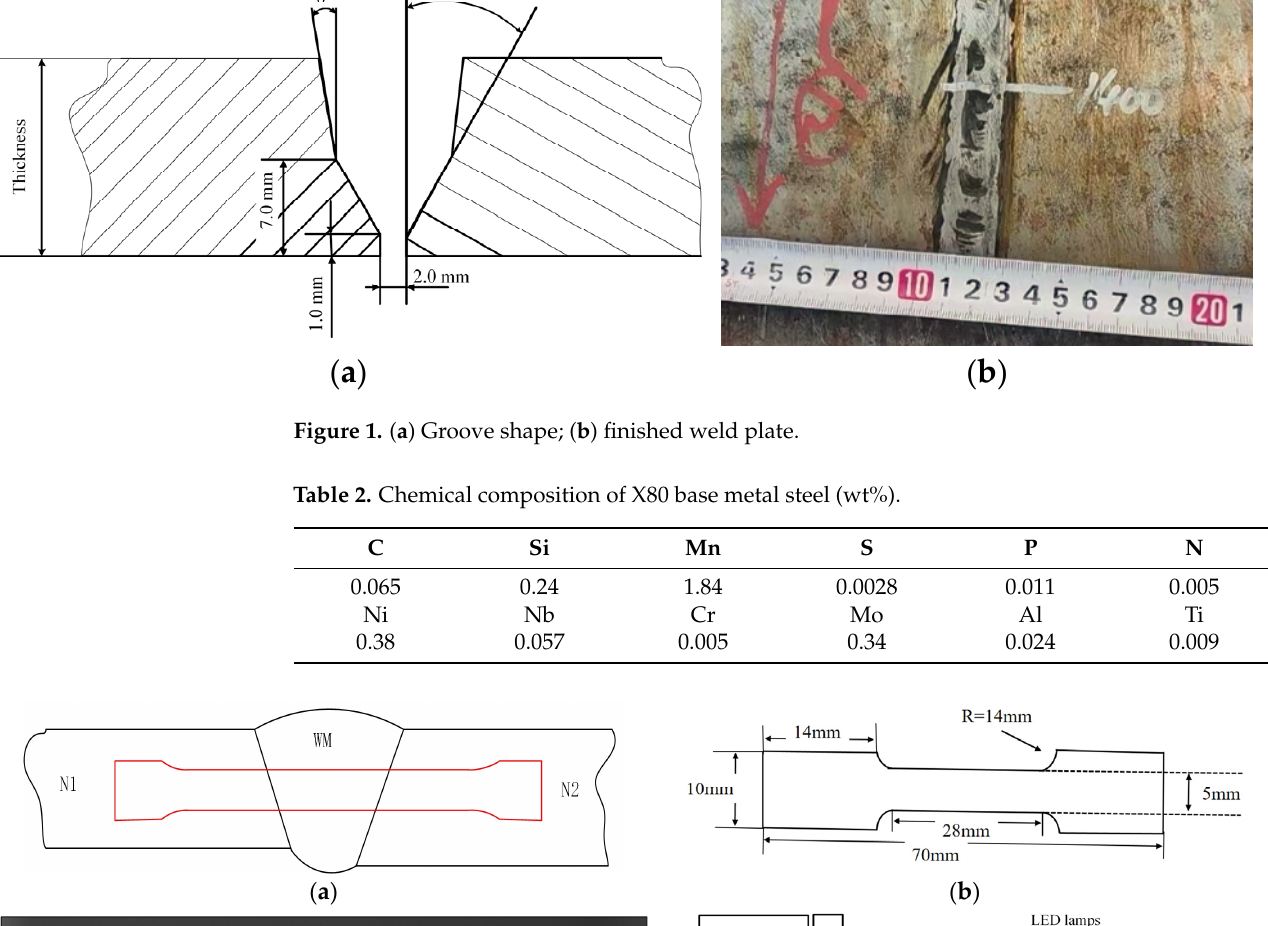
Table 1. Welding specifications and constant parameters.